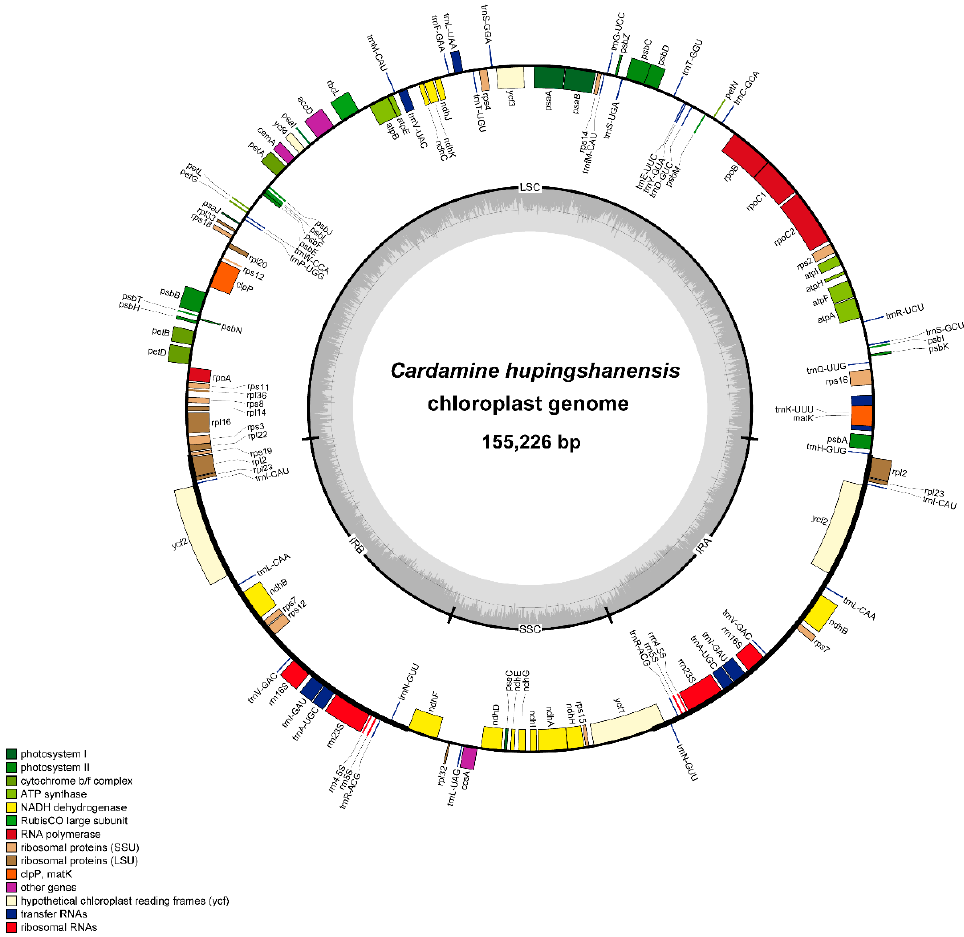
Figure 1. Gene maps of chloroplast genomes of Cardamine hupingshanensis . The colored bars indicate known protein-coding genes, tRNA and rRNA. The dark gray area in the inner circle indicates GC content, while the light gray area indicates AT content. LSC, large single copy; SSC, small single copy; IR, inverted repeats. Table 1. Summary of eighteen Cardamine chloroplast genome features.